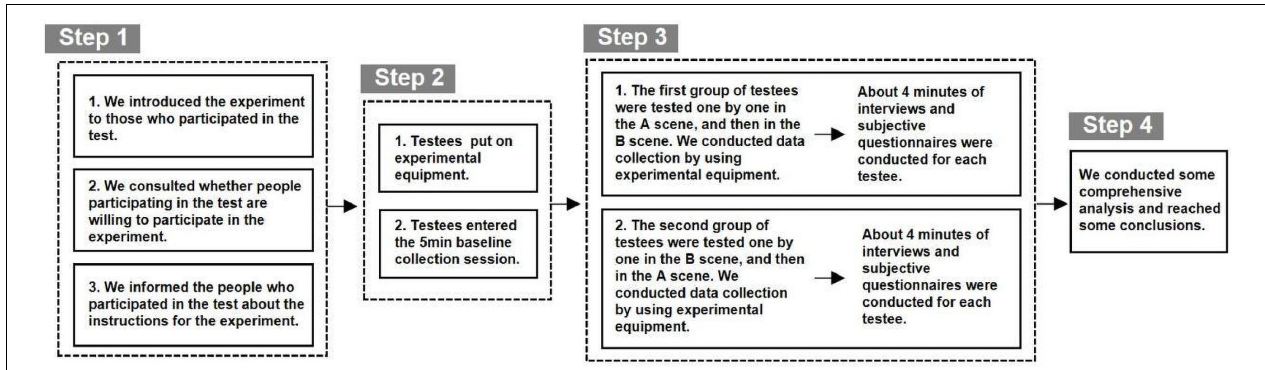
FIGURE 4 | Schematic diagram of the process of this experiment (Drawn by our research team).